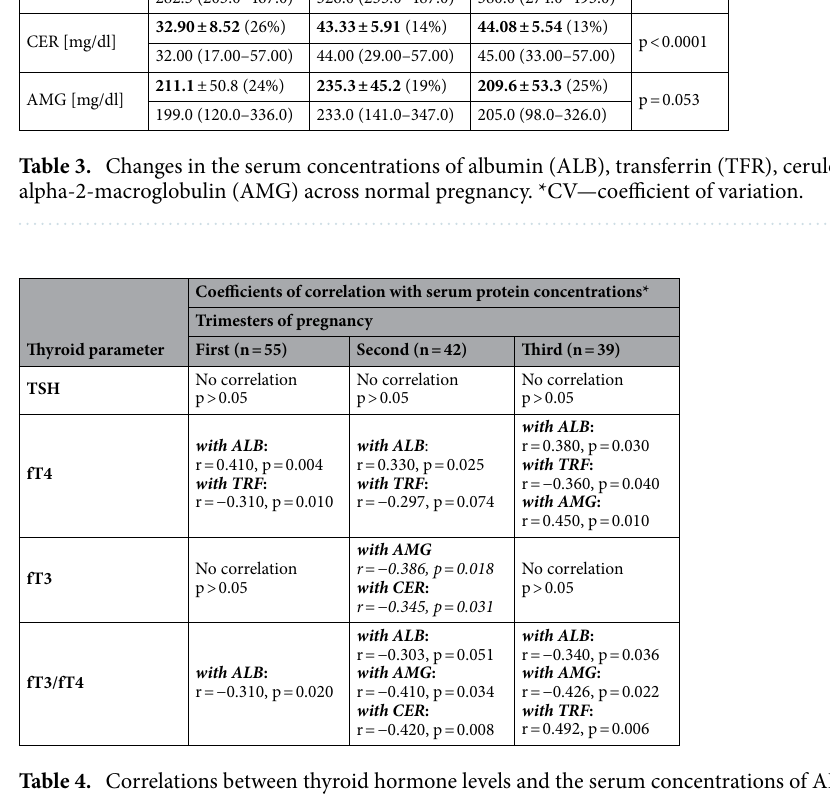
Figure 1 graphically represents the correlations between the serum concentrations of fT4 and of ALB and TFR in consecutive trimesters of pregnancy. Changes in the concentrations of ALB and of TRF regulated by changing fT4 levels were found to move in opposite directions throughout pregnancy.